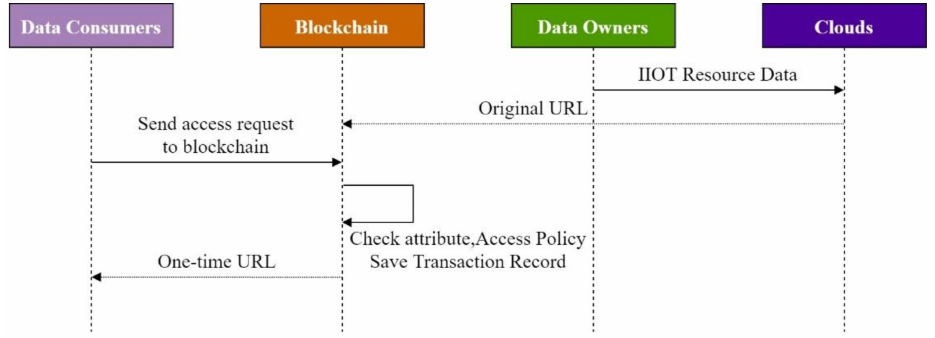
Figure 9. One-time URL context sequence